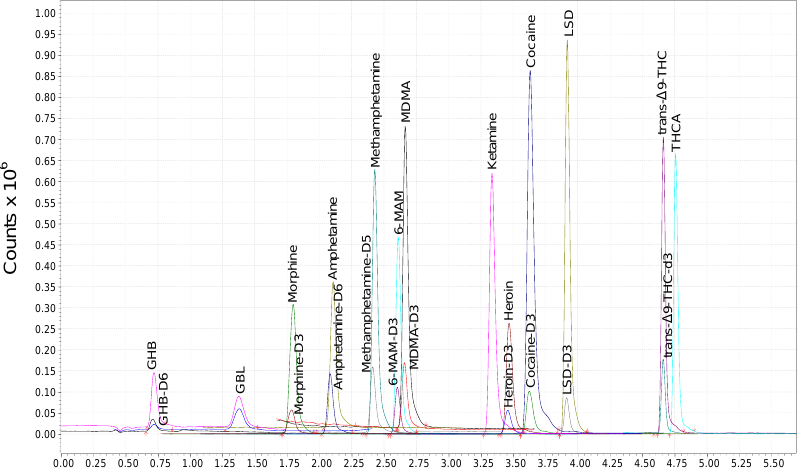
Figure 1. Chromatographic separation of a standard mixture of the target compounds (each at 50.0 ng mL − 1 ) and their relative ISs in SRM acquisition mode.